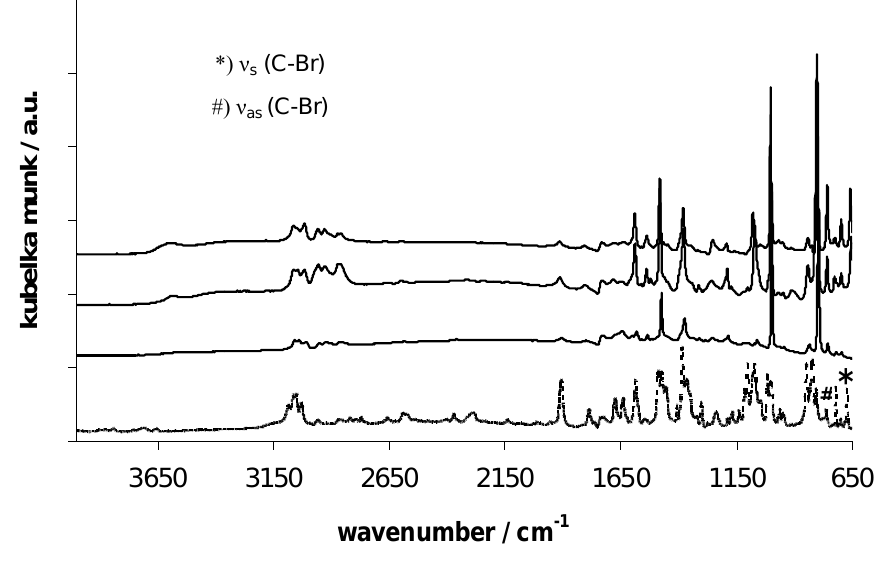
Figure 2. FT-IR spectra of EOF-3 (top), -4 (middle) and -5 (bottom) in comparison with 4,4’-dibrombiphenyl (dashed line).